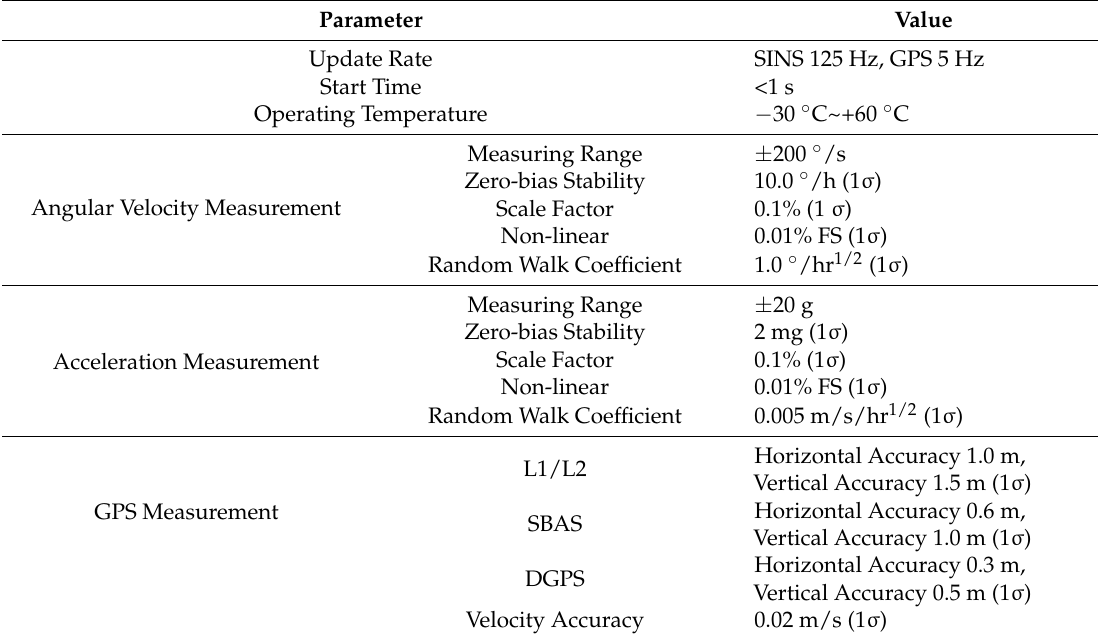
Table 2. The parameters of the SINS/GPS integrated navigation system.